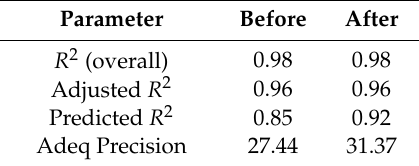
Table 7. R 2 parameter for average roughness (Sa) model before and after the backward elimination.